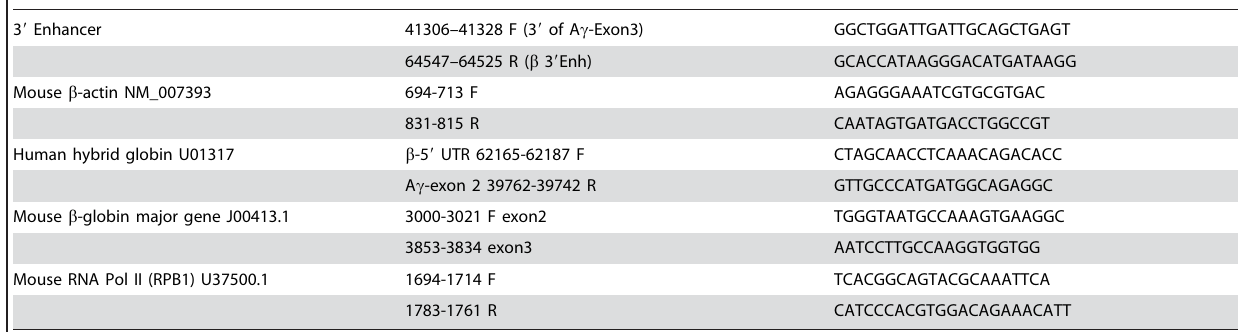
Table 1. Real-time PCR